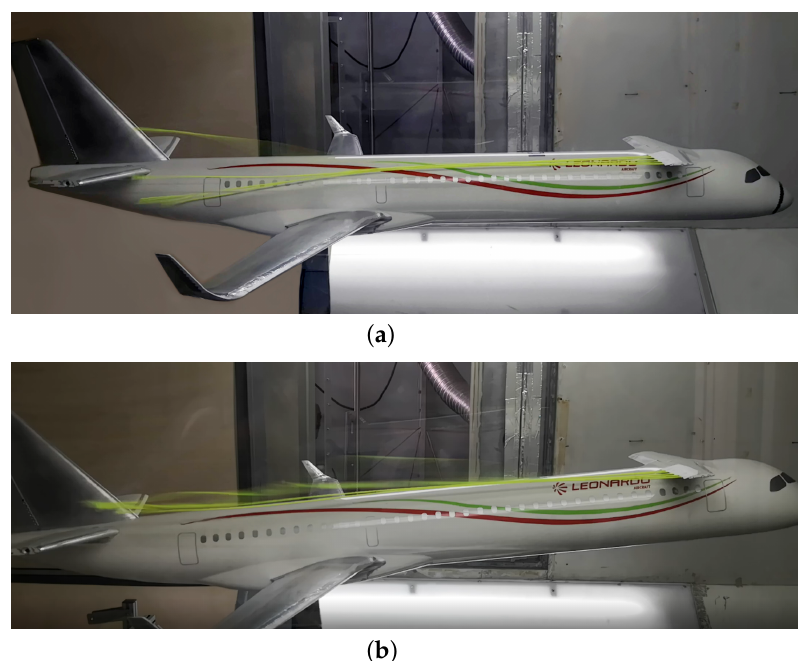
Figure 19. Displacement of the canard wake with respect to the horizontal tailplane: visualisation test through wool yarns: ( a ) α = 2°; ( b ) α = 6°. Table 10. Breakdown of direct and indirect propulsive effects on lift and pitching moment coefficient curve slope, complete aircraft configuration, experimental results. Re = 315,000, RPM = 8750 (CR), X CG at LE MAC. Derivative (deg − 1 ) Power-Off Indirect Effects